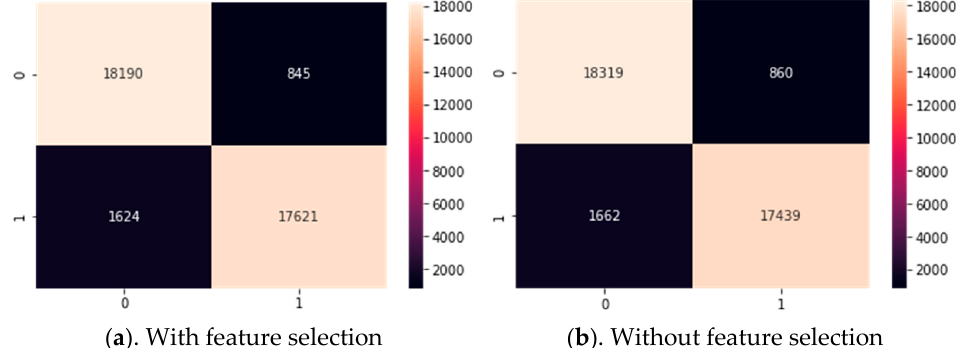
Figure 11. Confusion matrix of logistic regression algorithm.